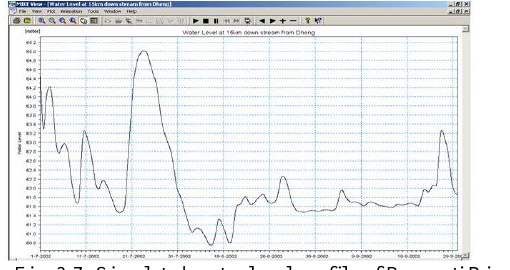
Fig. 3.7: Simulated water level profile of Bagmati River at the cross section, 15kms d/s from Dheng Table 2: Water levels comparison from current and